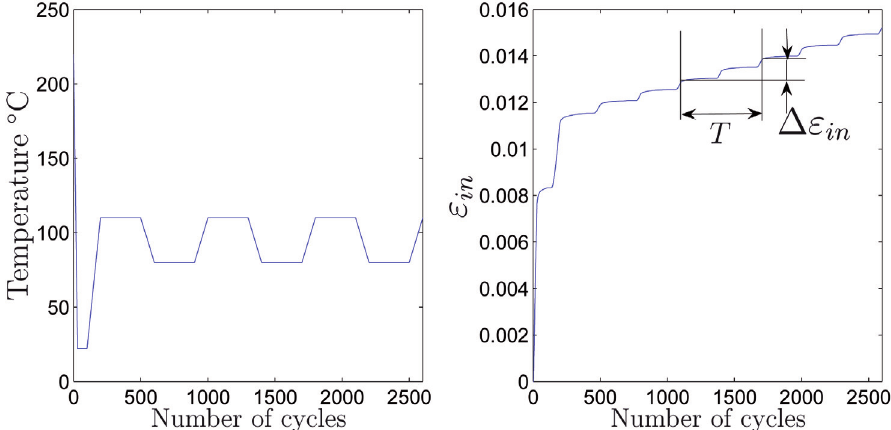
Fig. 4. Result temperature in chip and associated inelastic strain.